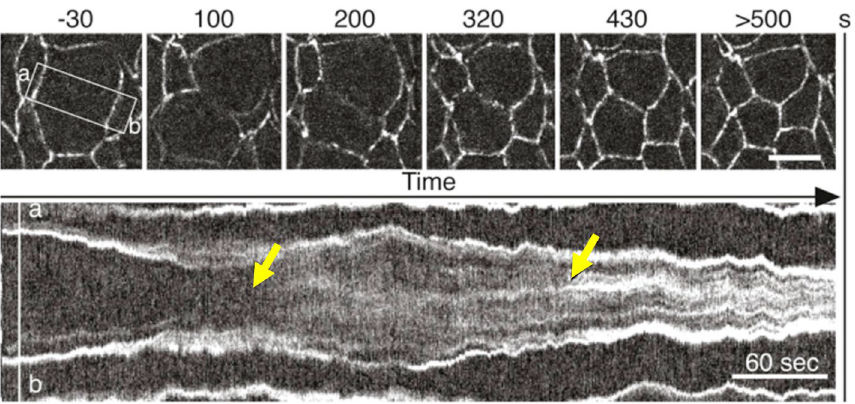
Figure 4. Evolution of cadherin density on the apical edge of a dividing epithelial cell during cytokinesis, reproduced with permission from 73 . Cadherins are labelled with E-cad::GFP fluorescent markers; the second panel (kymograph) shows the density along the [a-b] cross-section, illustrating how the interface area first expands and then contracts. During this time, the intensity profile of the cadherins increases sharply at two times indicated by arrows. Previous work on integrin and paxillin has shown an increase in the intensity of the fluorescent marker as the time of the first formation of focal adhesions 81 ; this increase in intensity could